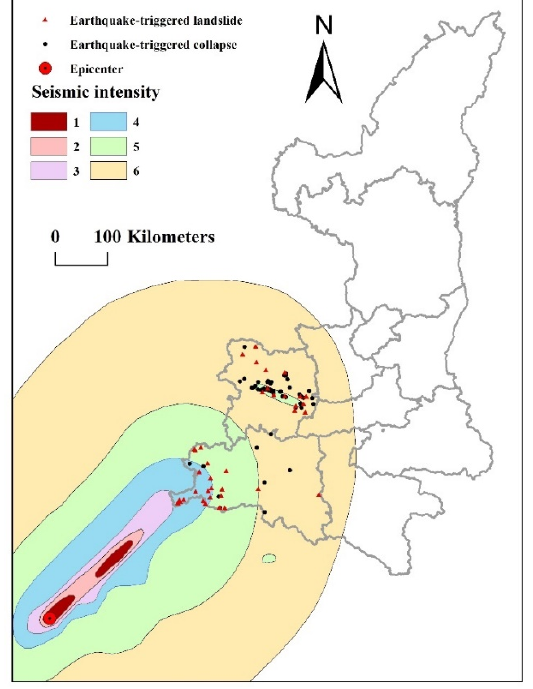
Figure 11. Spatial distribution of landslides triggered by the Wenchuan earthquake on 12 May 2008.